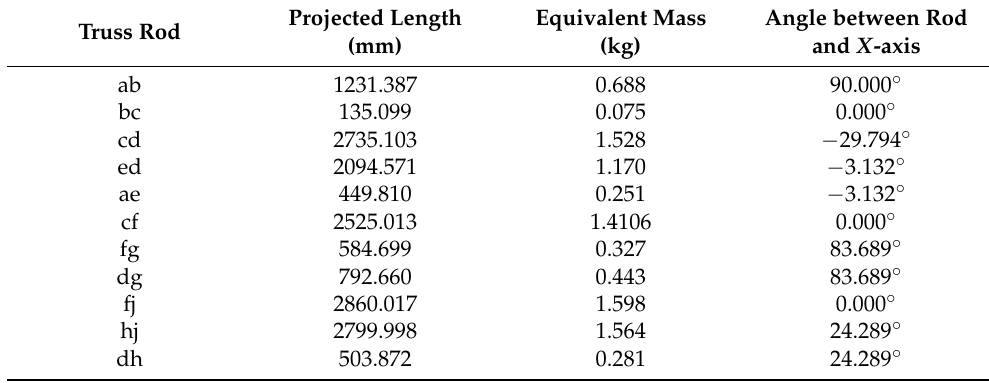
Table 3. Projected length, equivalent mass, and angle between rod and X -axis in X-O-Z